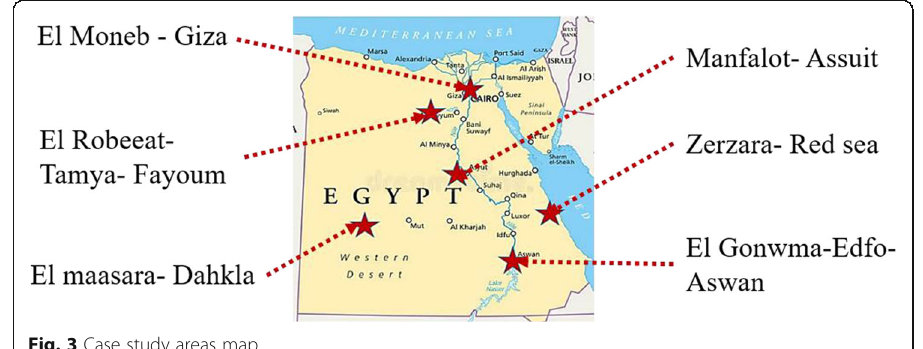
Fig. 3 Case study areas